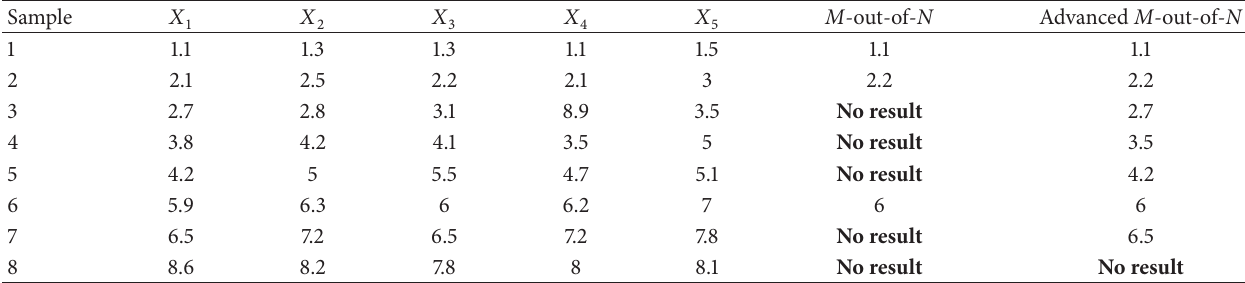
Table 1: The voters results for 8 consecutive voting